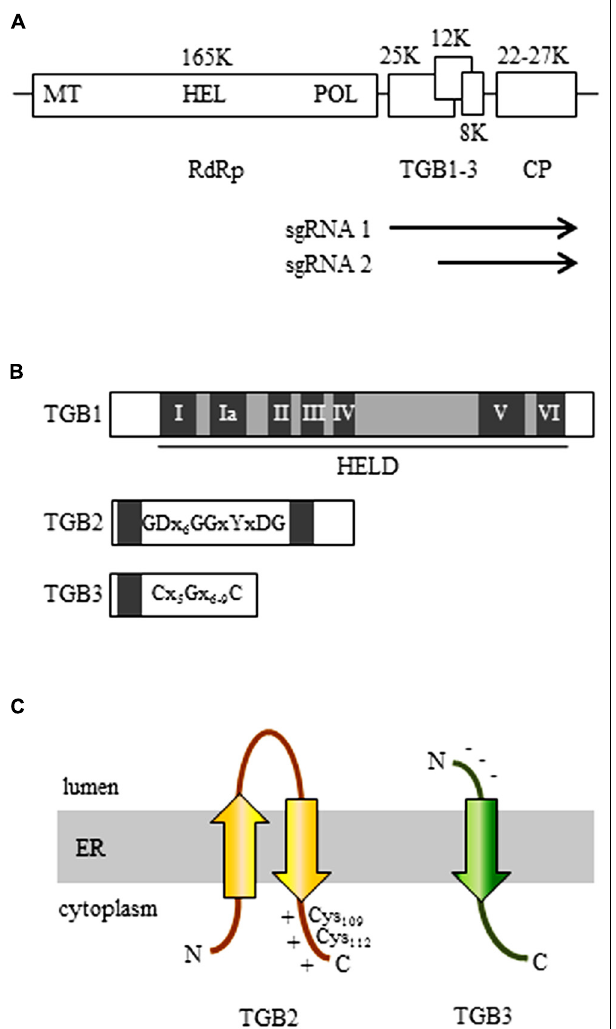
FIGURE 1 |The organization of the potexvirus genome. (A) The RNA-dependent RNA polymerase (RdRp, replicase) gene contains a methyltransferase domain (MET), a helicase domain (HEL), and an RNA polymerase domain (POL). The three genes of the triple gene block (TGB) are partially overlapped. Arrows indicate subgenomic (sg) RNAs for expression of TGBs. (B) The organization of the three TGB genes. TGB1: The first TGB ORF encodes the TGB1 protein and has a helicase-like domain (HELD), which contains seven typical motifs of a general helicase (I, Ia, II, III, IV, V, and VI; dark boxes). TGB2: the TGB2 protein is encoded in the second TGB ORF and has two transmembrane domains (dark boxes). The GDx 6 GGxYxDG sequence is conserved in TGB2-encoding viruses. TGB3: The TGB3 protein is encoded by the third TGB ORF and contains a transmembrane domain (dark box). Among the TGB3-encoding potexviruses, the TGB3 gene has a conserved C(x 5 )G(x 6 − 9 )C sequence. (C) 3-D structural models of TGB2 and TGB3 protein in the endoplasmic reticulum (ER). Potexvirus TGB2 protein integrates into ER membranes to form a U-like structure (with the central loop exposed to the ER lumen and with both the N- and C-terminus located in the ER cytoplasm) and has two conserved cysteine residues (Cys 109 and Cys 112 ) in the C-terminal region, which has a positive net charge (TGB2). Potexvirus TGB3 has an N-terminus that has a negative net charge and is exposed to the ER lumen and a C-terminus that is exposed to the ER cytoplasm (Morozov and Solovyev,